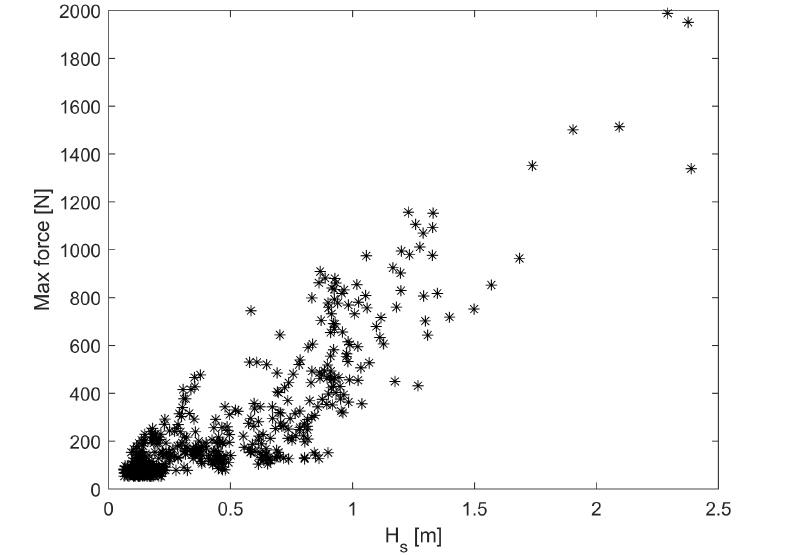
Figure 6. The maximum force for each sea state are plotted versus the significant wave height. Data shows a trend with higher max forces for higher wave heights, see Figure 6. However, there are also several deviations from the pattern. Sea states with the same significant wave height show huge differences in measured